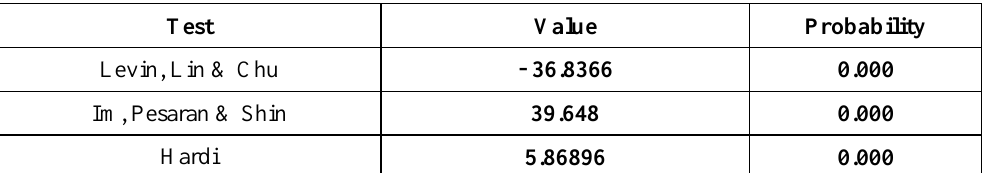
Table 3. Reliability test of local